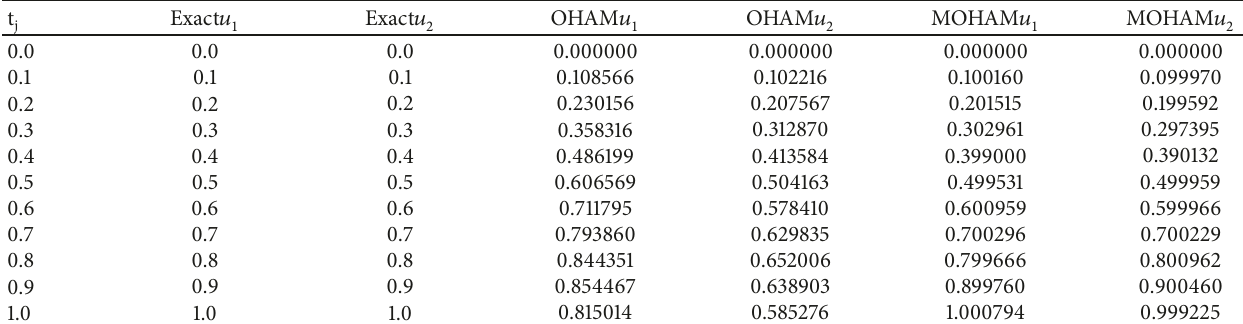
Table 5: The results of applying OHAM, MOHAM, and the exact solution for Example